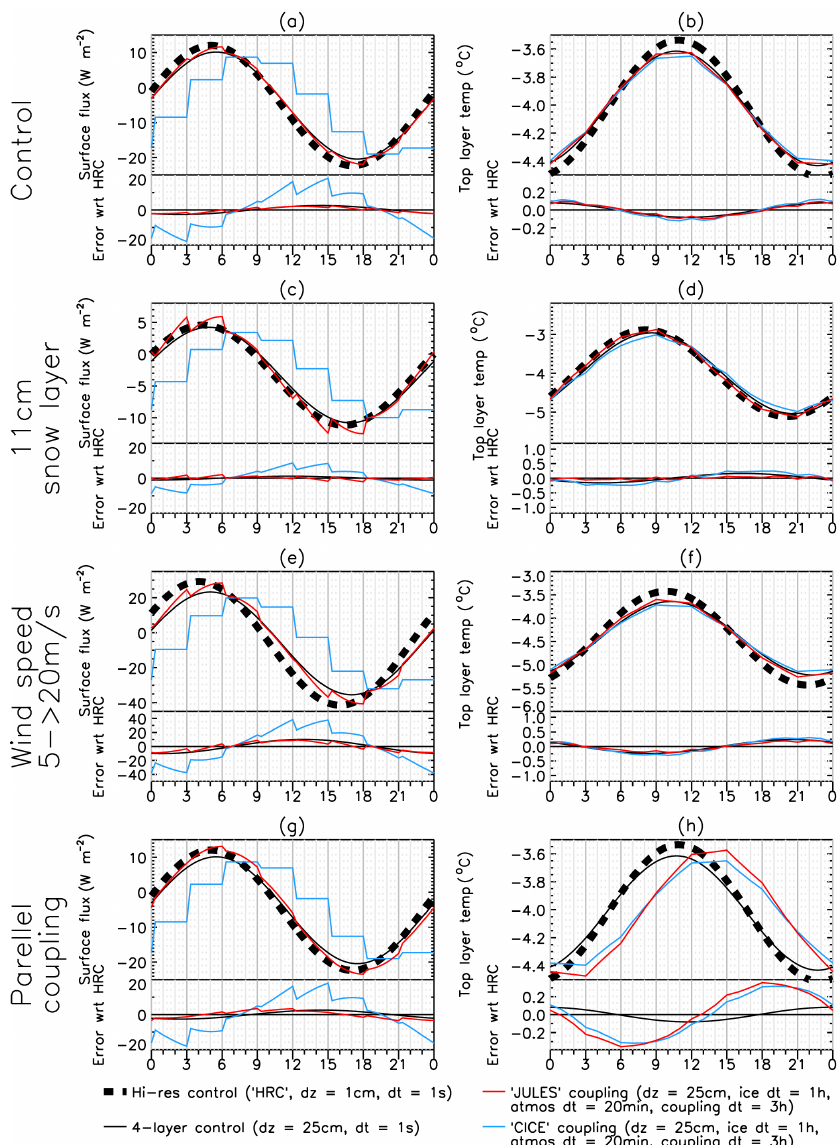
Figure 6. Demonstrating the performance of the two coupling methods when the parameters of the experiment are varied. Showing surface flux (left) and top-layer temperature (right) for (a, b) original experiment; (c, d) an experiment in which an 11cm snow layer was present on the ice; (e, f) an experiment in which wind speed was increased from 5 to 20ms − 1 ; (g, h) an experiment in which parallel, rather than serial, coupling was employed. For the snow layer experiment, the top-layer temperature represents the temperature of the snow layer; for all others, it represents the temperature of the top ice